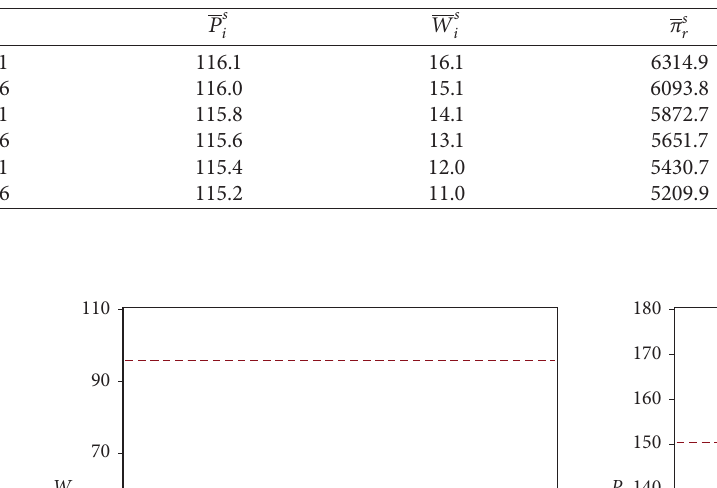
Table 5: Effect of change in other parameters when manufacturers allocate fairness